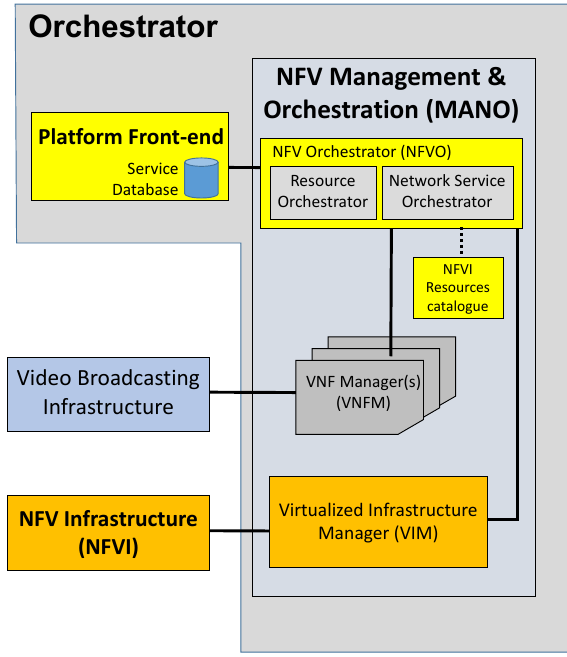
Figure 4. Orchestrator architecture. NFV: network functions virtualization